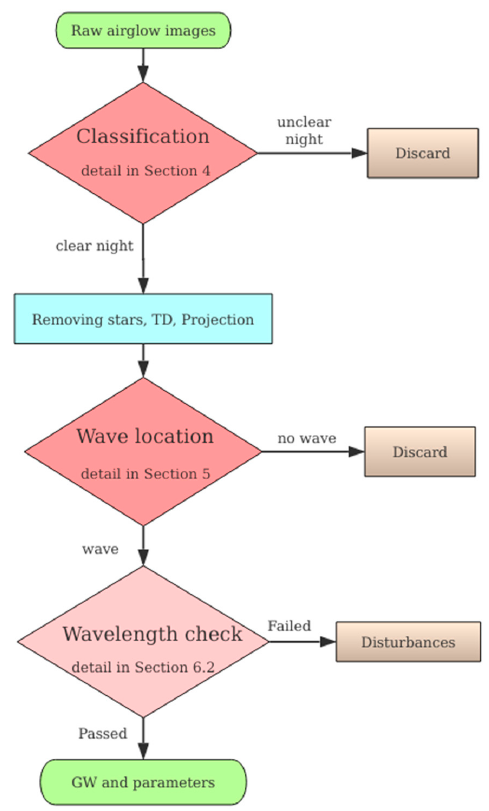
Figure 1. The frame of the automatic extraction program. There are three identification steps to obtain images of gravity waves (GWs): classification (Section 4), wave location (Section 5), and wavelength check (Section 6.2). The classification and wave location steps, marked by red in the figure, are both performed by models trained by machine learning.